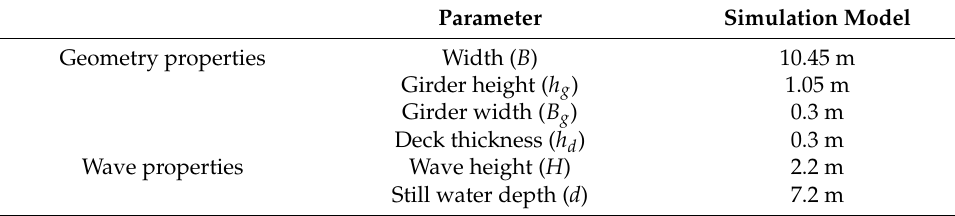
Table 2. The parameters of the girder model and wave used in the study of Xu and Cai [36]. Parameter Simulation Model Geometry properties